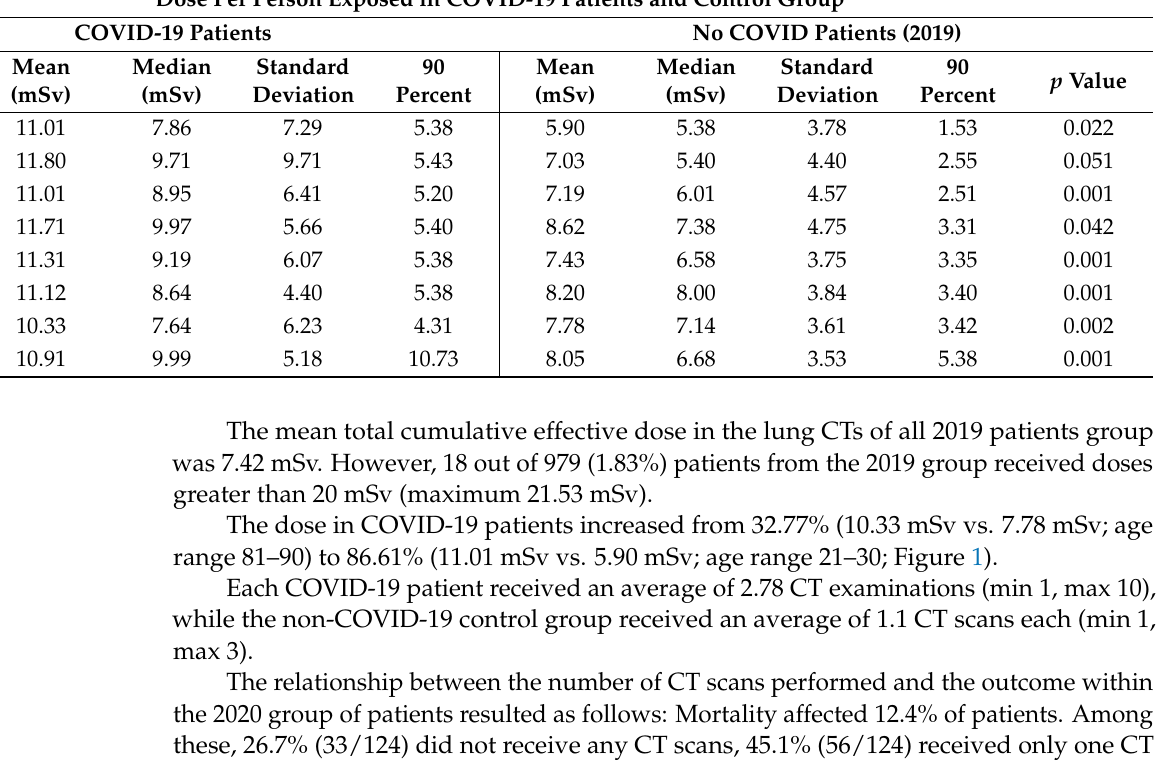
Table 3. Comparison between doses in COVID-19 and non-COVID-19 patients by age group. Dose Per Person Exposed in COVID-19 Patients and Control